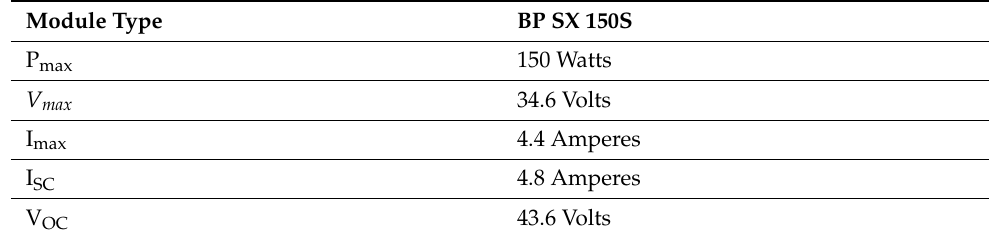
Figure 2. PV cell equivalent circuit. Table 1. Parameters of PV